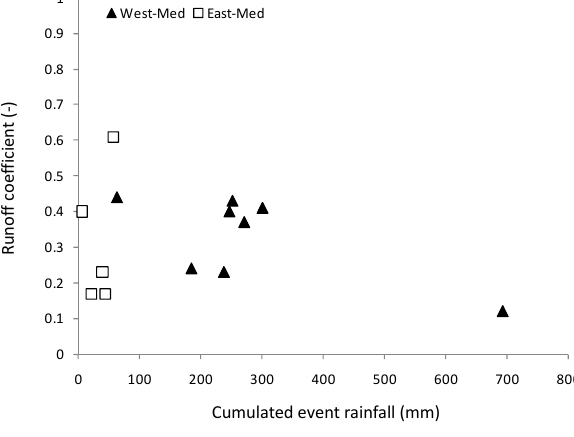
Fig. 7. Relation between event runoff coefficient and event cumu- lated